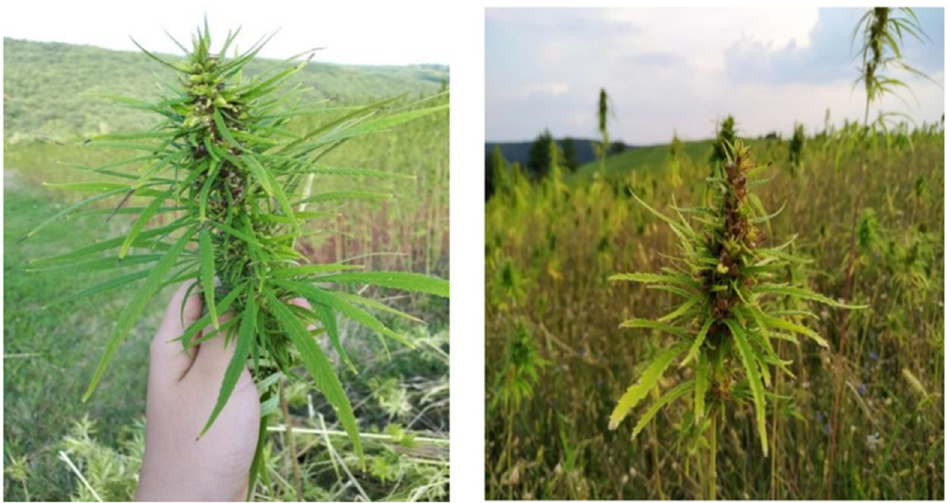
Figure 1. Appearance of hemp ( Cannabis sativa Linn.) [13] .